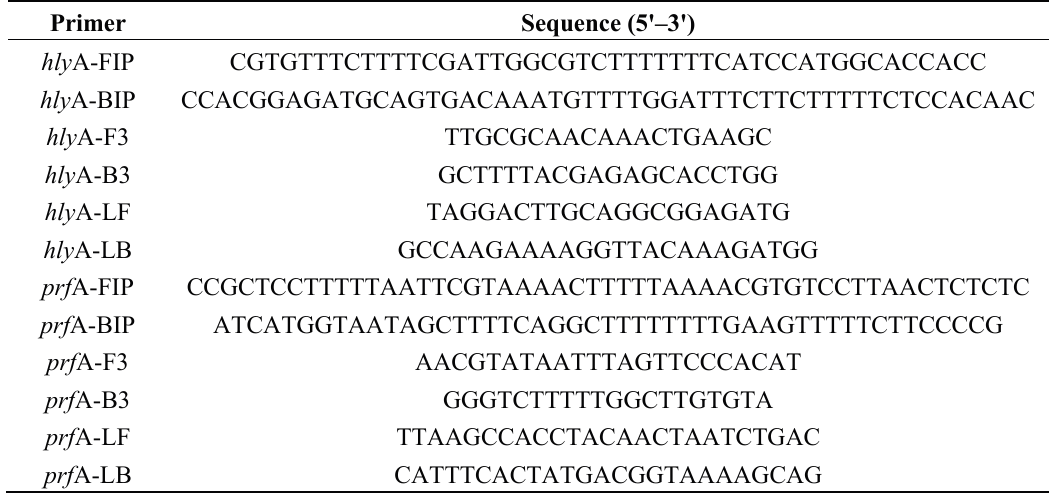
Table 5. Primers for detecting prf A of L. monocytogenes with